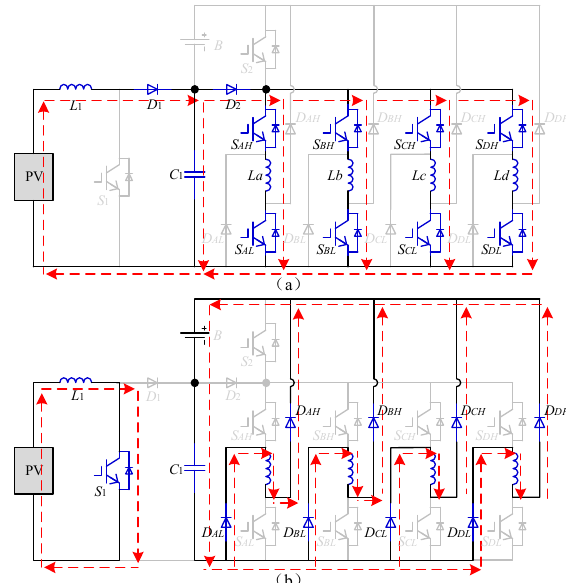
Figure 10. Working states of the charging